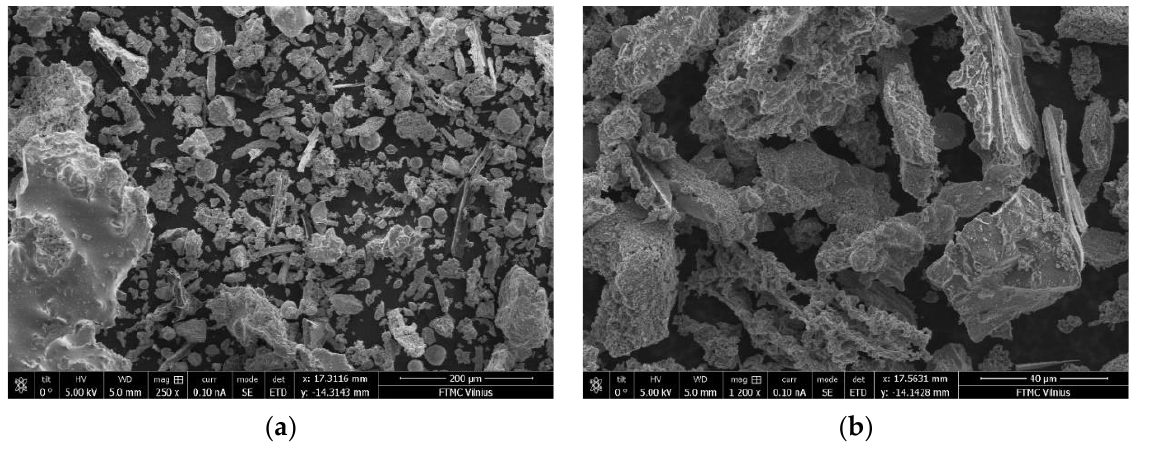
Figure 6. SEM images of the BFA. Magnification: ( a ) 250 and ( b ) 1200. It can be observed that the TG/DTA curves of the BFA have one exothermic effect in